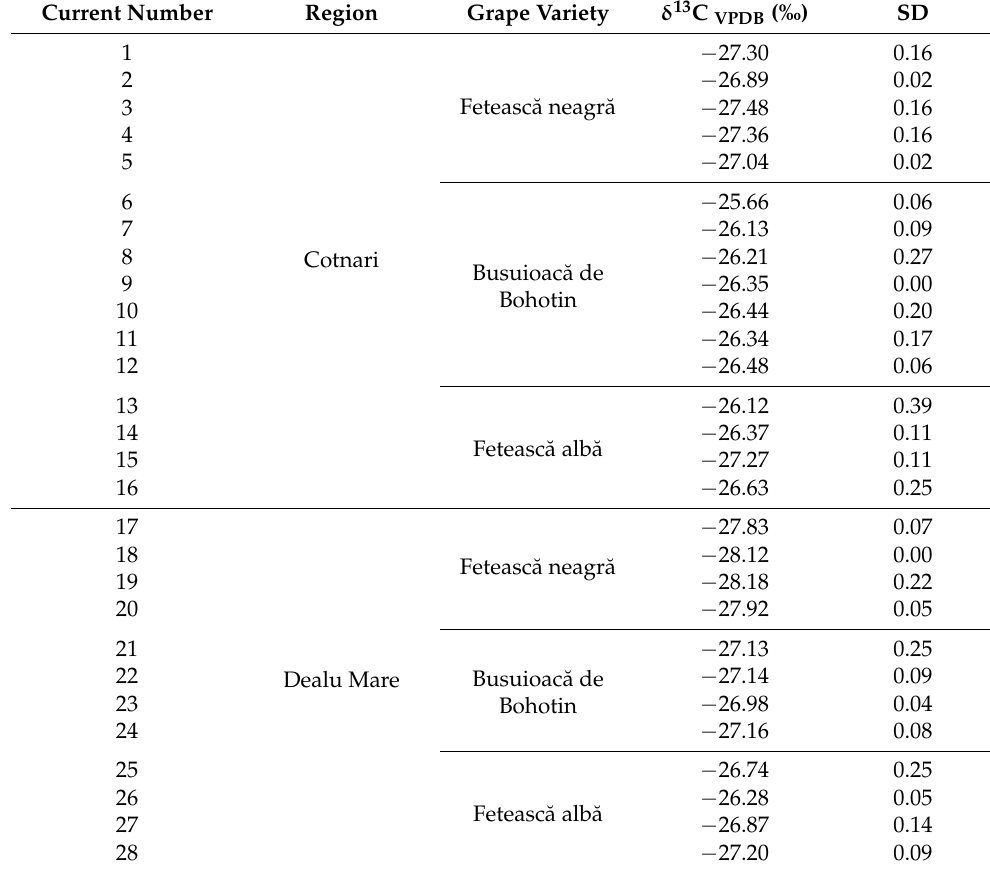
Table 3. Carbon isotope ratios ( δ 13